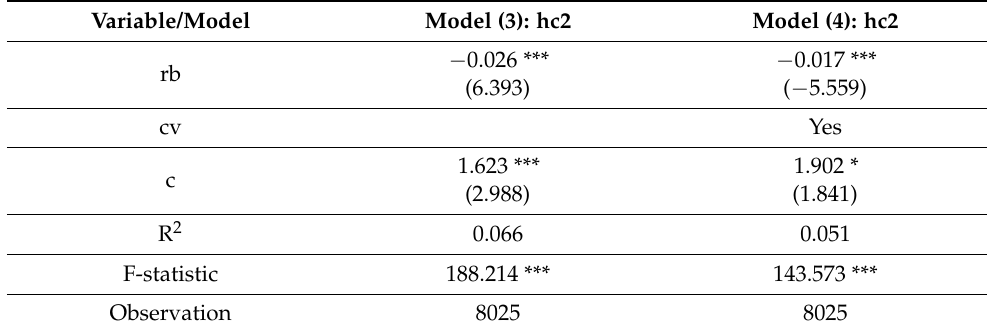
Table 4. Results of robustness test